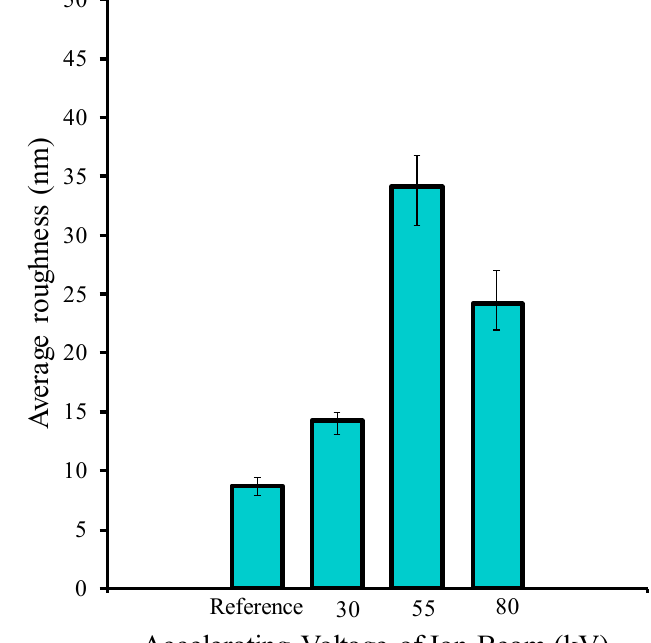
Figure 4. Surface average roughness of samples.